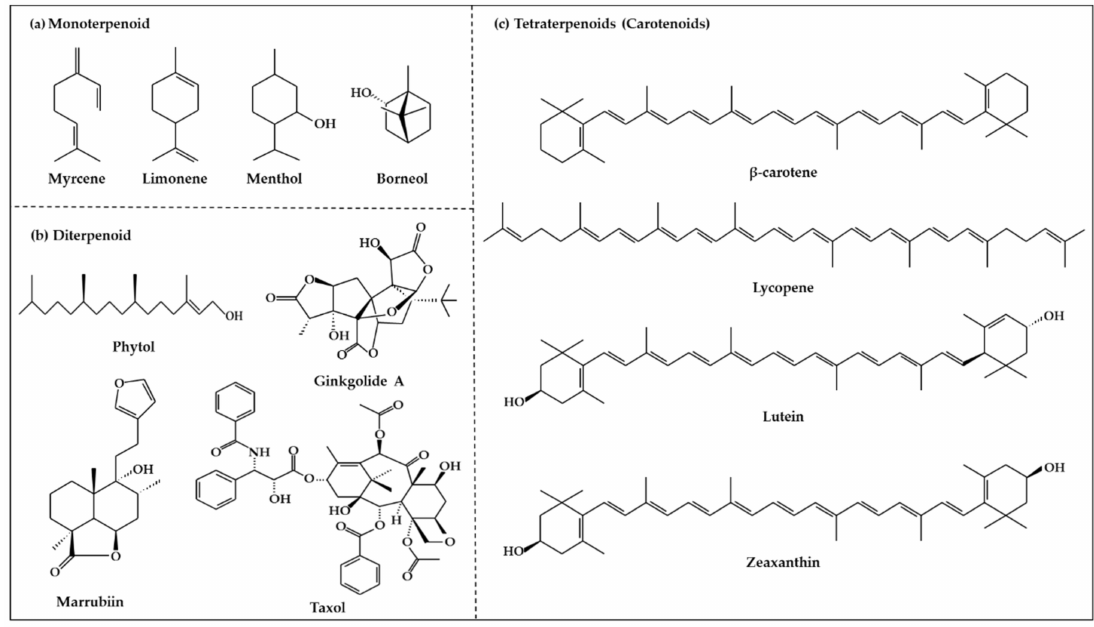
Figure 2. Structure of